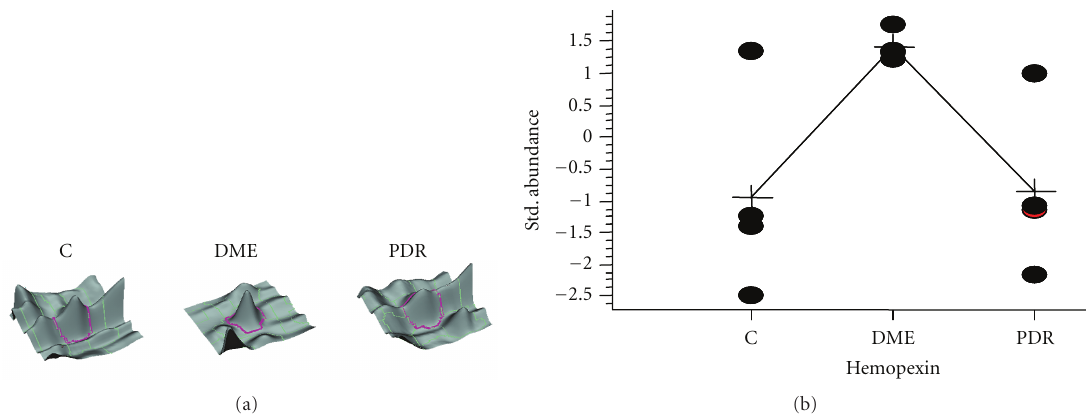
Figure 2: Results obtained by using the fluorescence-based di ff erence gel electrophoresis (DIGE) strategy showing the higher abundance of hemopexin in the vitreous fluid of diabetic patients with DME in comparison with Nondiabetic controls and PDR patients. (a) Three- dimensional images of the hemopexin spot corresponding to the image of a control (C), DME, and PDR samples. (b) Standardised abundance plot for hemopexin displaying the log of abundance observed for the spot in each of the four gel images corresponding to control (C), DME, and PDR samples. The line links the average abundance values for each group of samples (crosses). Student’s t test results in a significant increase ( P < 0 . 05) in DME sample in comparison with either C or PDR